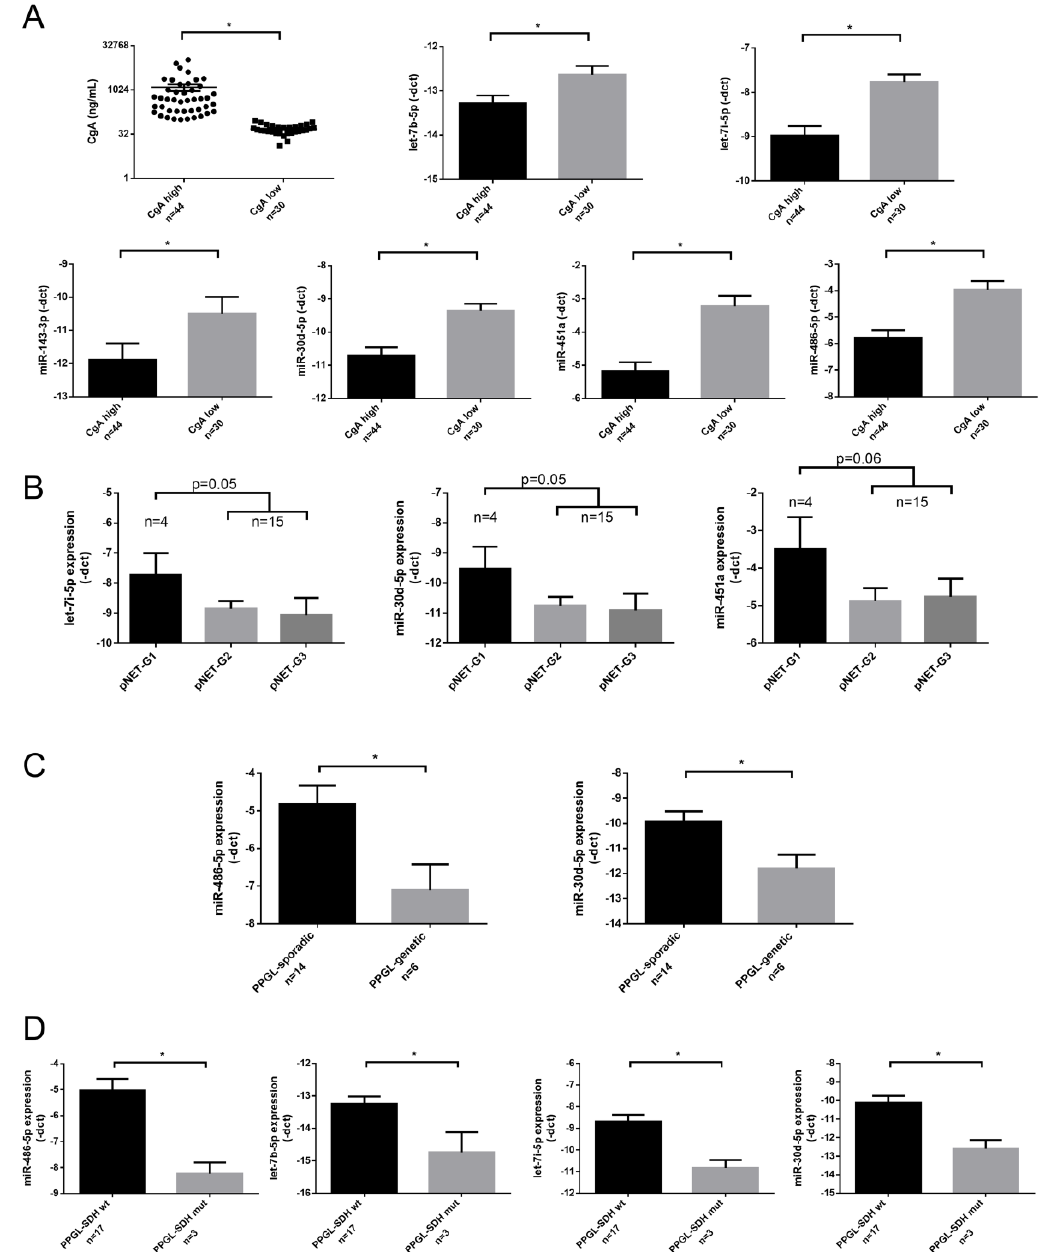
Figure 3. Individual qPCR validation of miRNAs in CgA high vs. CgA low samples ( A ), among pNET samples with different grade ( B ), in sporadic vs. genetically predisposed PPGL ( C ), and in SDHB mutation associated vs. non-associated PPGL ( D ). Error bars indicate mean ± SE. * represents p -value < 0.05 .